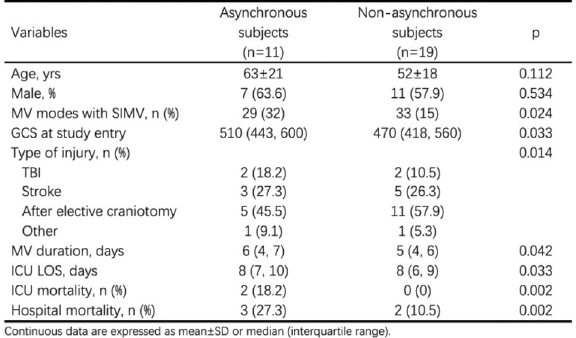
Table 2 (abstract 000314). Variables in asynchronous and non- asynchronous